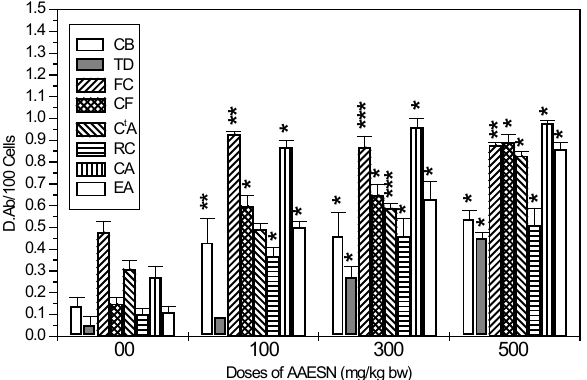
Fig. 2. Influence of AAESN on WRBMCs in terms of different chromosomal abnormalities. * Significant at p<0.05, ** at p<0.01 and *** at p<0.001 as compared to the control by 2x2 contingency χ2-test (d.f.=1). The data were represented as Mean±SEM. D.Ab./Cell: Dif- ferent abnormalities per cell scored; CB: Chromatid break; TD: Ter- minal deletion; FC: fragmented chromosome; CF: Centric fusion; C t A: Centromeric association; RC: Ring chromosome; CA: Chro- mosomal association; EA: End to end